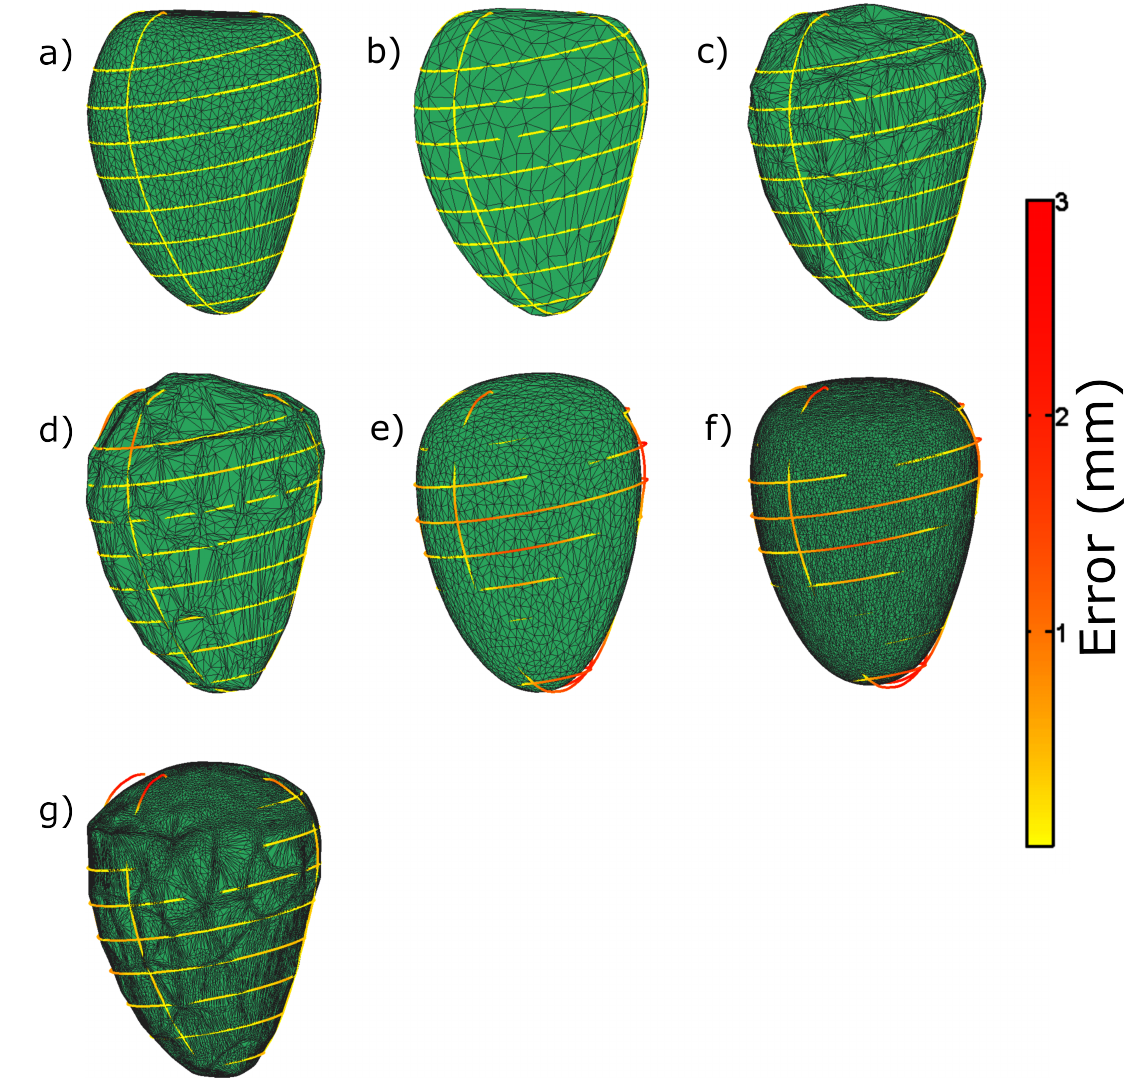
Figure A1. Illustration of resulting meshes for different extreme sets of parameters in the exploration and tuning of the parameters experiment. The color along the contours represents the distance to the resulting mesh. See the main text in Appendix A for comments on the different